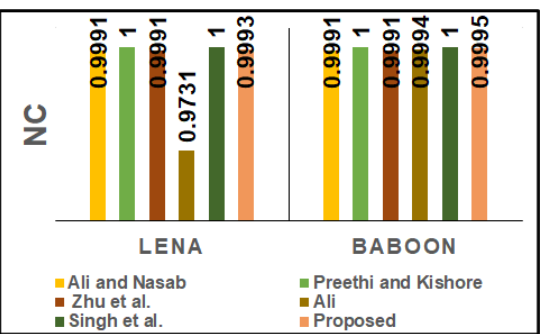
Figure 12. NC comparison of our method against state-of-the-art methods for Lena and Baboon images under zero